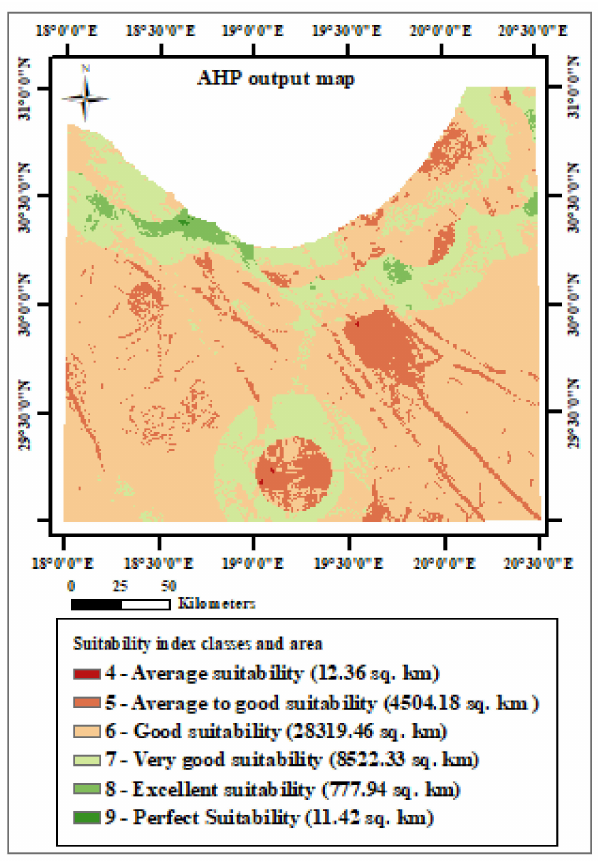
Figure 8. Output map of applying AHP